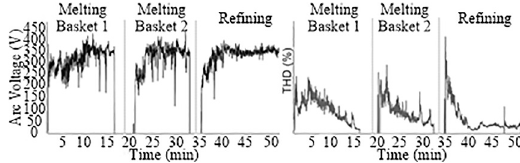
Figure 6: Arc voltage behavior (left) and THD (right) during a